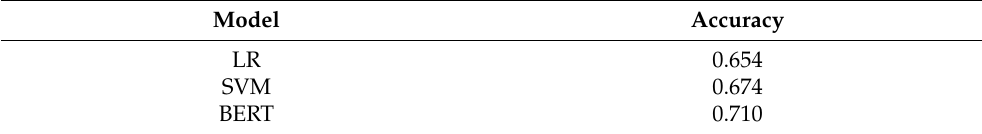
Table 1. The accuracy of